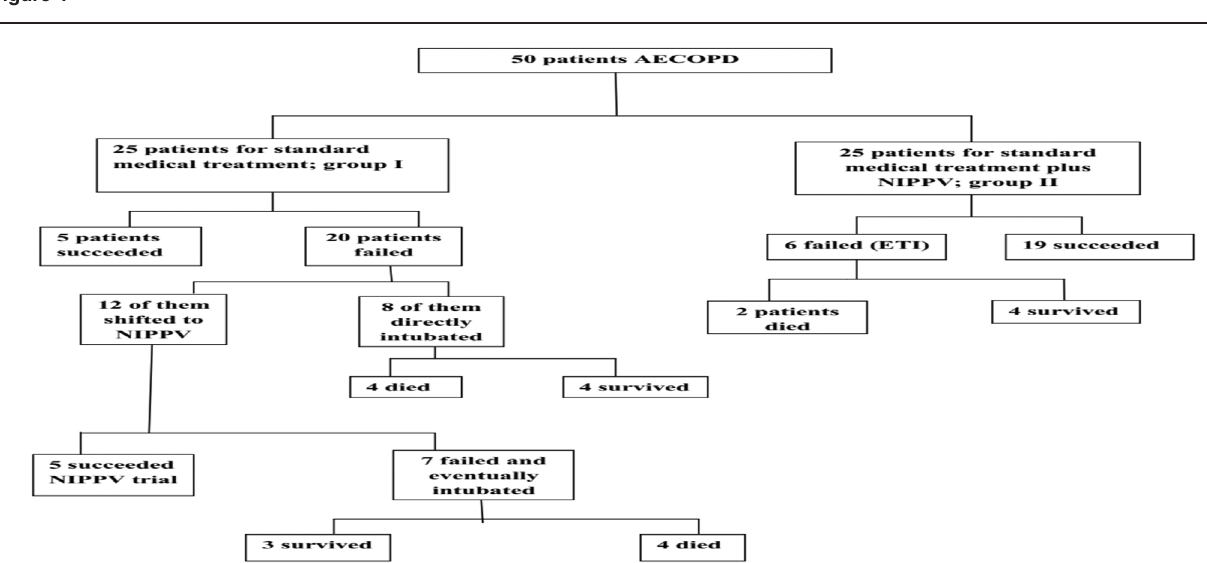
Flow diagram illustrating the detailed outcome of all cases throughout the study